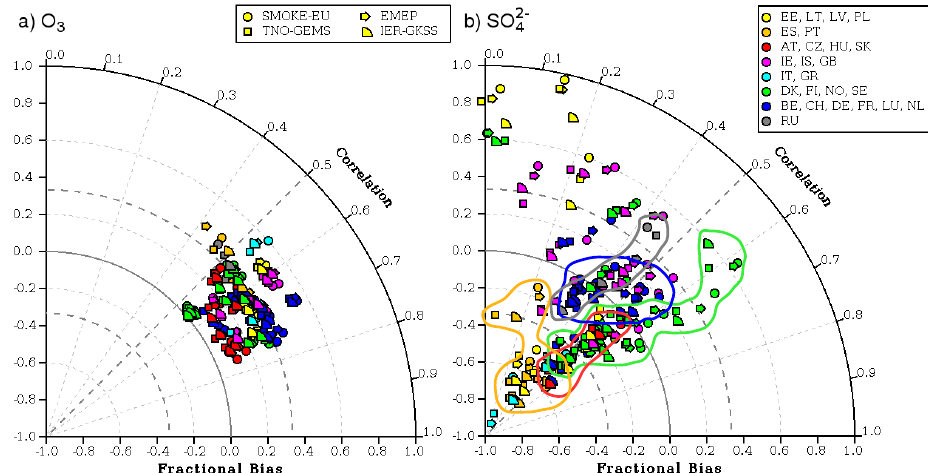
Fig. 15. Diagrams showing correlation and fractional bias of modelled atmospheric concentrations for the year 2000 of (a) O 3 and (b) SO 2 − compared to observations. Unlike in standard Tylor diagrams the fractional bias is shown on the radial axis. Different shapes indicate the 4 emission datasets used, while different colours indicate geographical regions. The location of all measurement stations as well as the description of the regions is depicted in Fig. 12.